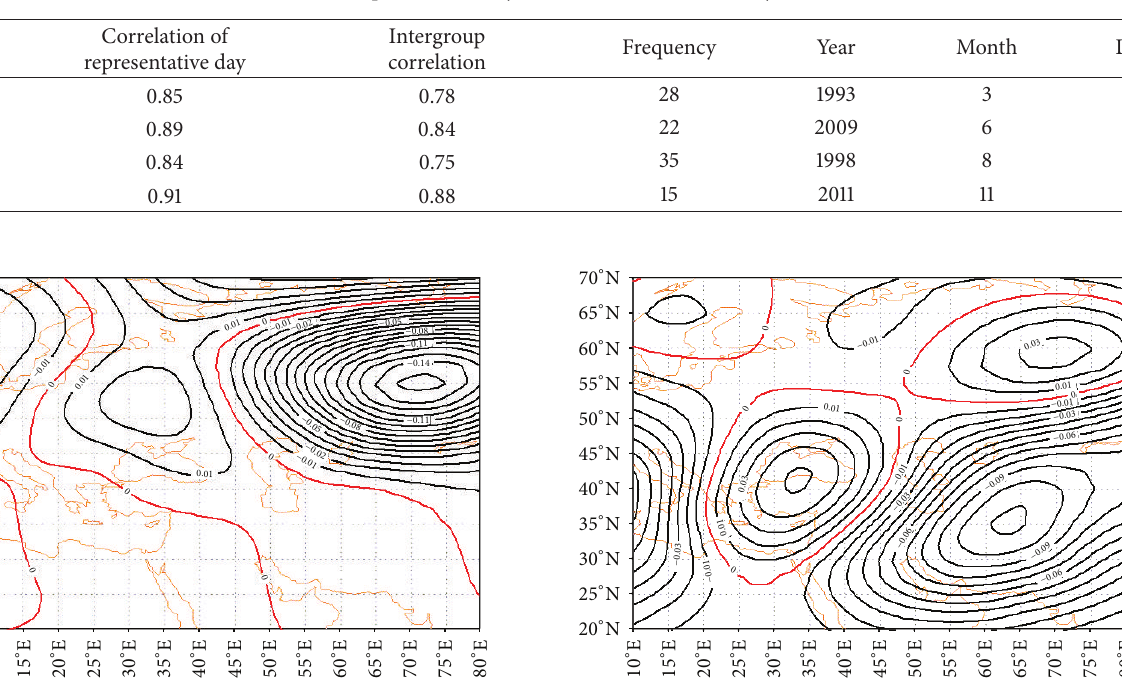
Table 5: Representative days obtained from cluster analysis.